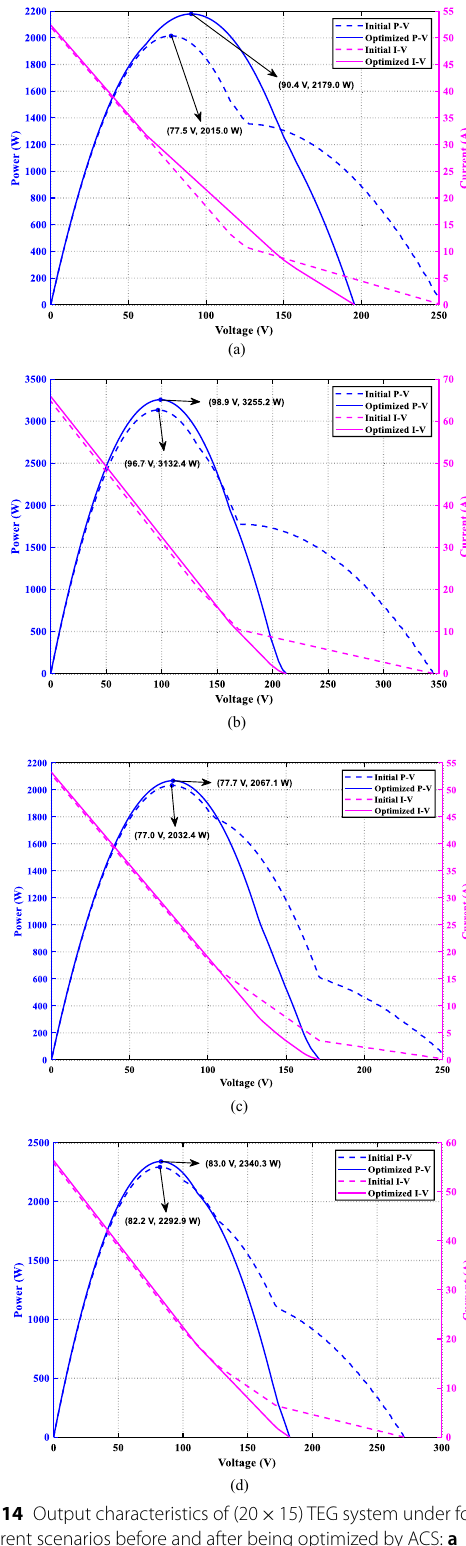
Fig. 14 Output characteristics of (20 different scenarios before and after being optimized by ACS: a diagonal, b outer, c inner, and d